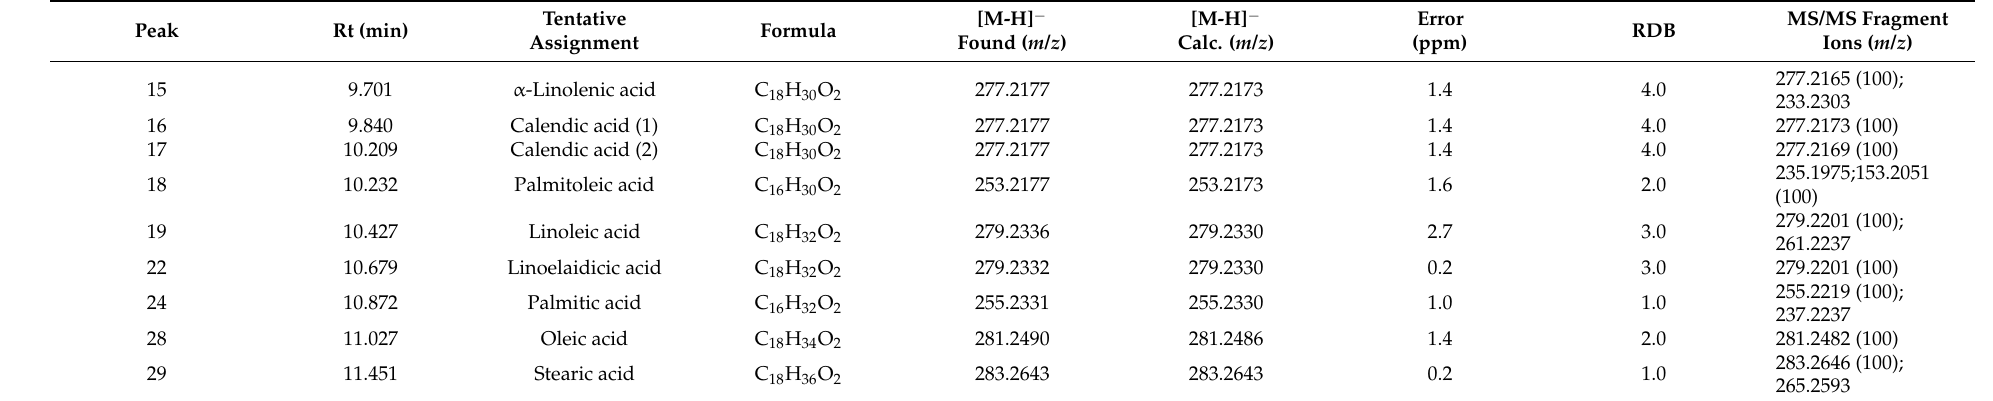
Table 1. TOF-MS and MS/MS data of FAs tentatively identified in apolar extracts from the different Calendula arvensis organs. Peak numbers are based on elution order in the whole reversed-phase chromatograms (RDB: ring and double bond).